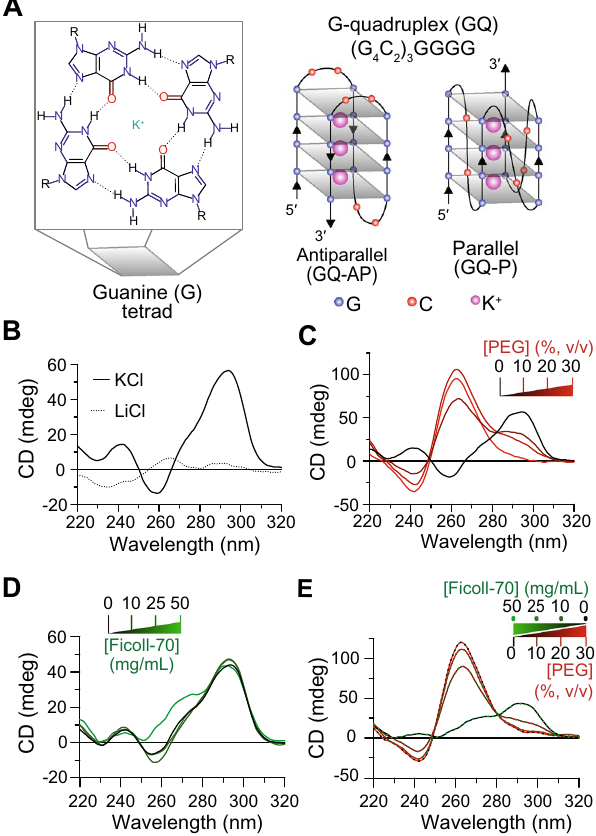
Figure 1. Molecular crowding conditions can impact GQ structural preferences of the C9-NRE DNA. (A) Schematic representation of the guanine tetrad that stack to form an anti-parallel (left) and/or parallel (right) DNA G-quadruplex topologies adopted by the C9-NRE. Gray planes depict the Guanine tetrads. Blue, red, and purple spheres represent guanine residues, cytosine residues, and potassium ions, respectively. ( B ) Representative CD spectra of C9- 22mer oligo, 10 µM, in the presence of 100 mM KCl (solid line) or 100 mM LiCl (dotted line) at 25 °C demonstrate that K + promotes the formation of GQ-AP. ( C ) Representative CD spectrum for the C9 -22mer oligo in the presence of 100 mM KCl and increasing molecular crowding agent of 0, 10, 20, and 30% [PEG-200] (v/v) are denoted by the black to red line transition. ( D ) CD spectrum for the C9 - 22mer in the presence of increasing molecular crowding agent 0, 10, 25, and 50 [Ficoll-70] (mg/mL) are denoted by the black to green line transition. ( E ) Representative CD spectrum for decreasing [Ficoll-70] combined with increasing [PEG-200] are shown for the C9 -22mer